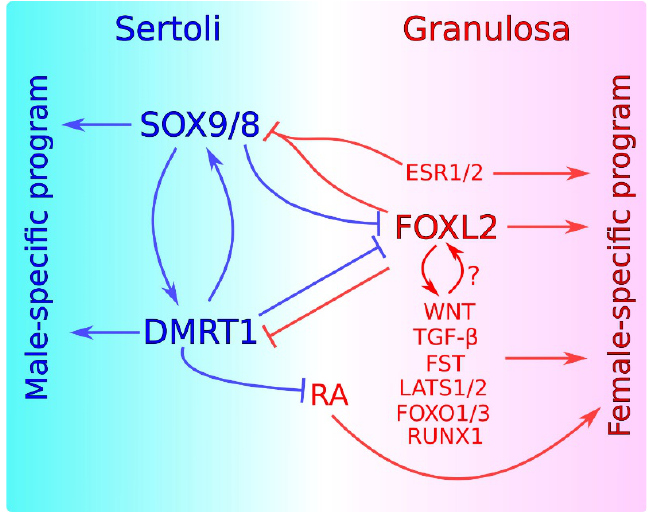
Figure 2. Current model for the maintenance of sex-specific supporting cell fates in adult gonads. In Sertoli cells, SOX9/8 establish a feed-forward regulatory loop with DMRT1, necessary for the maintenance of the male-specific program and for preventing the expression of ovary-promoting genes including FOXL2. DMRT1 inhibits RA signaling, which induces the expression of ovarian genes. In granulosa cells, FOXL2 interacts with ESR1/2 and probably with other genes and molecular pathways including WNT, TGFβ, FST, LATS1/2, FOXO1/3, and RUNX1 to maintain the female - specific program. FOXL2 together with ESR1/2 negatively regulates SOX9/8 and/or DMRT1. Male- and female-promoting genes are in blue and red, respectively. Blue and red lines represent an action exerted by male- and female-promoting genes, respectively. Positive regulation is indicated by arrows. Negative regulation is indicated by perpendicular lines.